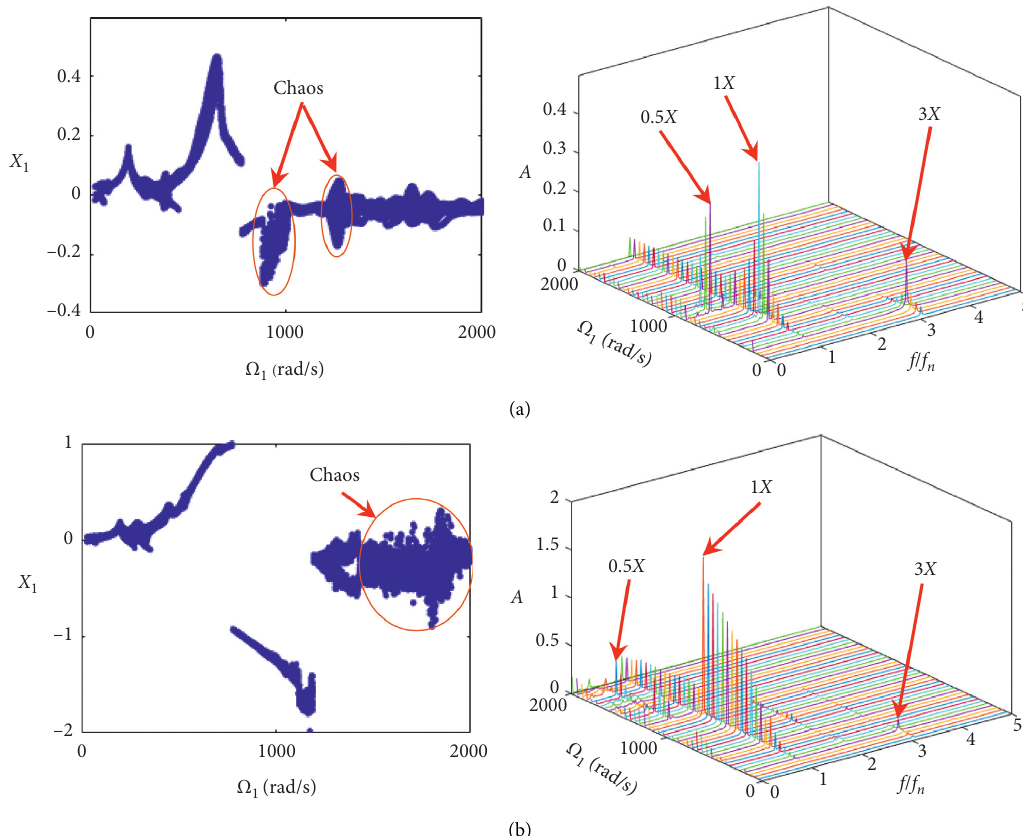
Figure 7: The bifurcation and waterfall chart when (a) e � 0.002mm, c k � 3 × 10 16 N/m 3 1